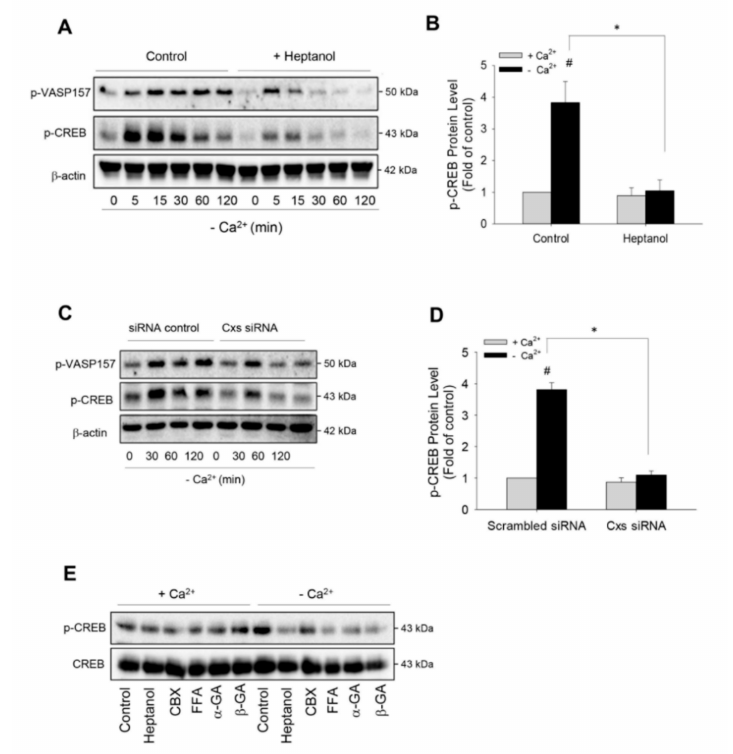
Figure 2. E ff ects of dysfunction of hemichannels on low Ca 2 + -induced activation of cAMP signaling pathway. ( A ) E ff ect of hemichannel inhibitor heptanol on PKA activation. As4.1 cells were pretreated with or without 3 mM heptanol for 30 min, then exposed to Ca 2 + -free medium in the presence or absence of heptanol for the indicated time intervals. Cellular proteins were extracted and subjected to Western blot analysis for the phosphorylated levels of VASP and CREB. β -actin was used as a loading control. ( B ) Desitometric quantitation of the phosphorylated level of CREB. The intensities of p-CREB signal at the time point of 30 min were measured using the Scion Image software. The data are expressed as relative intensity of the band against the control (mean ± SE, n = 4). # p < 0.01 versus normal Ca 2 + control; * p < 0.01 versus heptanol-treated cells. ( C ) E ff ect of siRNA treatment on cAMP signaling pathway. As4.1 cells were treated with siRNA control or siRNA cocktail targeting against Cxs37, 40, 43 and 45 for 24 h and exposed to Ca 2 + -free medium for the indicated times. The levels of phosphorylated VASP157 and phosphorylated CREB were evaluated by Western blot analysis. ( D ) Densitometric quantitation of the phosphorylated level of CREB at 30 min point shown in C. The data are expressed as relative intensity of the band against the control (mean ± SE, n = 3). # p < 0.01 versus normal Ca 2 + control; * p < 0.01 vs. siRNA-treated cells. ( E ) E ff ect of various gap junction inhibitors on low Ca 2 + -induced CREB phosphorylation. As4.1 cells were treated with 3 mM heptanol, 100 µ M CBX, 50 µ M FFA, 10 µ M α -or β -GA in the way same as A and analyzed for the phosphorylated and